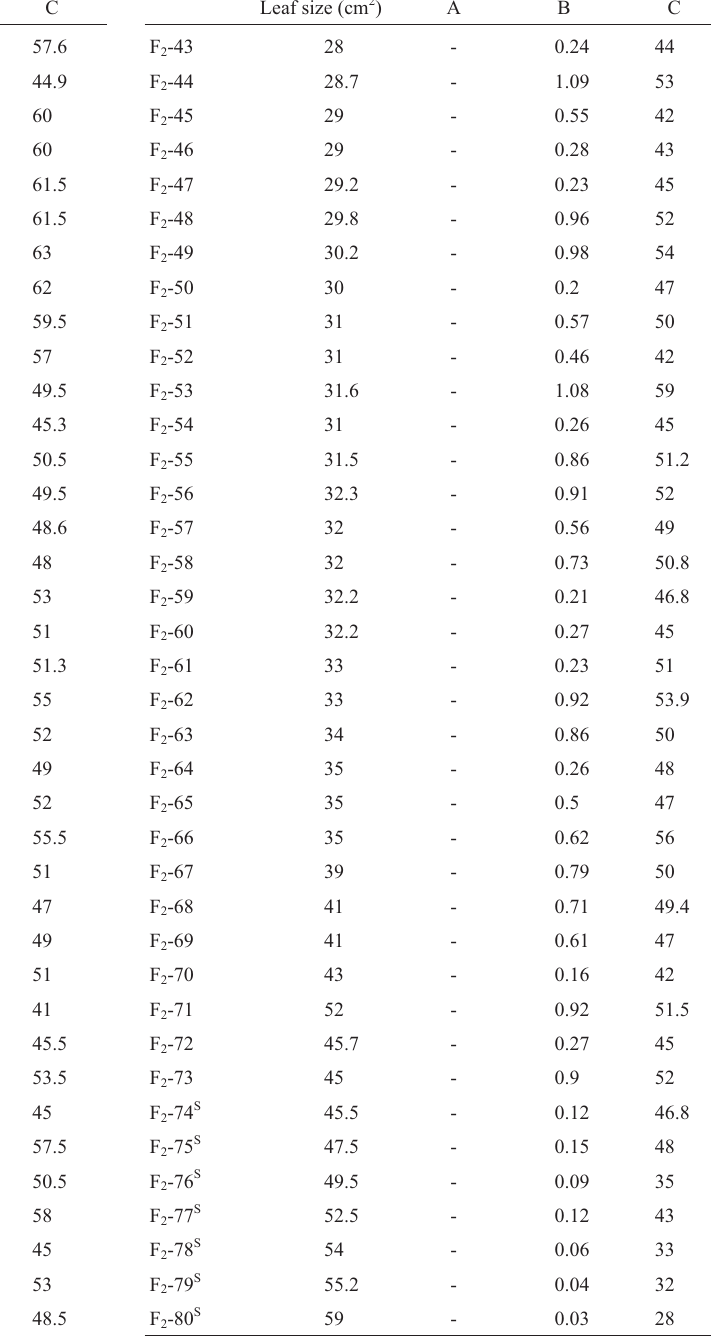
*Values presented for parental genotypes are averages of data from 20 pa- rental plants. A: Chlorophyll content in untreated leaves (mg/chloro- phyll/fresh weight). B: Chlorophyll content in PQ treated leaves (mg/ chlorophyll/fresh weight). C: RWC on 6 th day of water stress.